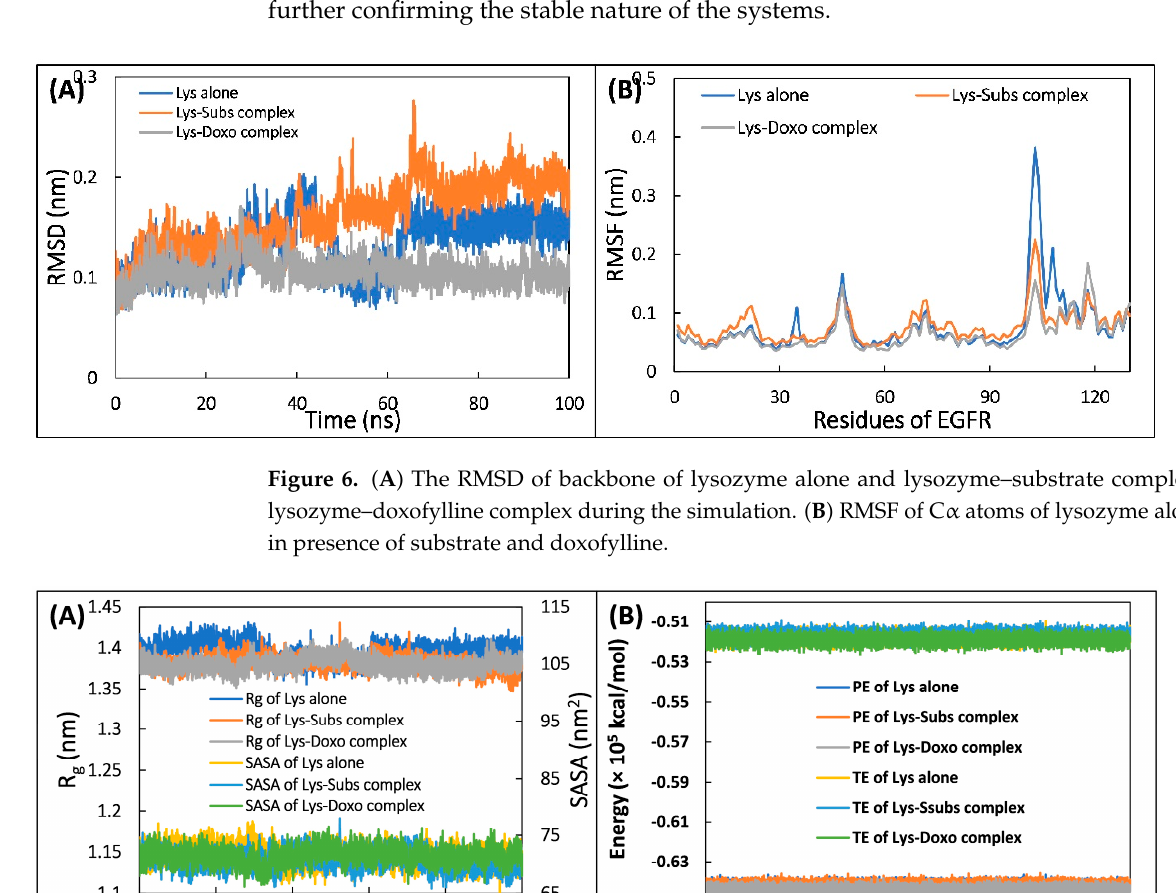
7 of 16 Figure 5. ( A ) Overlap of the docked structure of doxofylline with the original lysozyme–substrate complex. The doxofylline occupied same biding site as that of the substrate of lysozyme. Lysozyme is shown in ribbon model, doxofylline is shown as blue sticks, and substrate is shown as red sticks. ( B ) Two-dimensional view of the interaction of doxofylline with lysozyme. 2.7. Molecular Dynamic Simulation The MD simulation was carried out in presence of physiological concentration of salt at 310 K to mimic the physiological conditions. The PBC corrections were done to the tra- jectories before their analysis. At fi rst, analysis of the stability of trajectories was per- formed by calculating the RMSD (Figure 6A). The data shows that all systems were well equilibrated and trajectories did not show much deviations, showing that the systems were well stable [34]. The average RMSD of lysozyme alone, lysozyme–substrate complex,